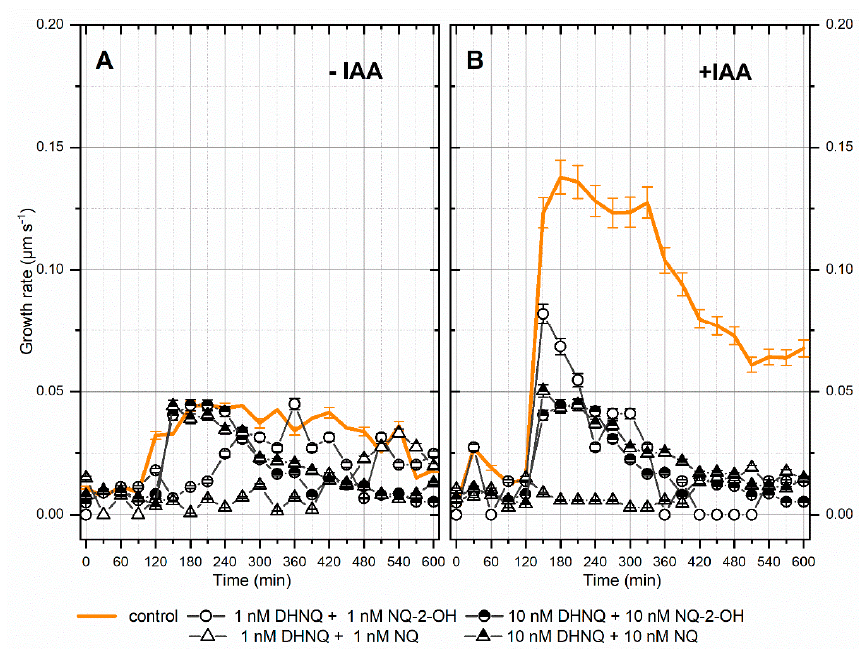
Figure 1. The effect of DHNQ combined with NQ-2-OH or NQ on the growth rate ( µ m s − 1 ) of the maize coleoptile segments that had been incubated ( A ) without and ( B ) with IAA. The coleoptile segments were preincubated (over 1 h) in a control medium, after which the naphthoquinones were added. IAA was added to the incubation medium at 2 h. For the sake of clarity, the data were shown in 30 min intervals. The presented data is the mean of six independent experiments. Bars indicate the means ± SEs.